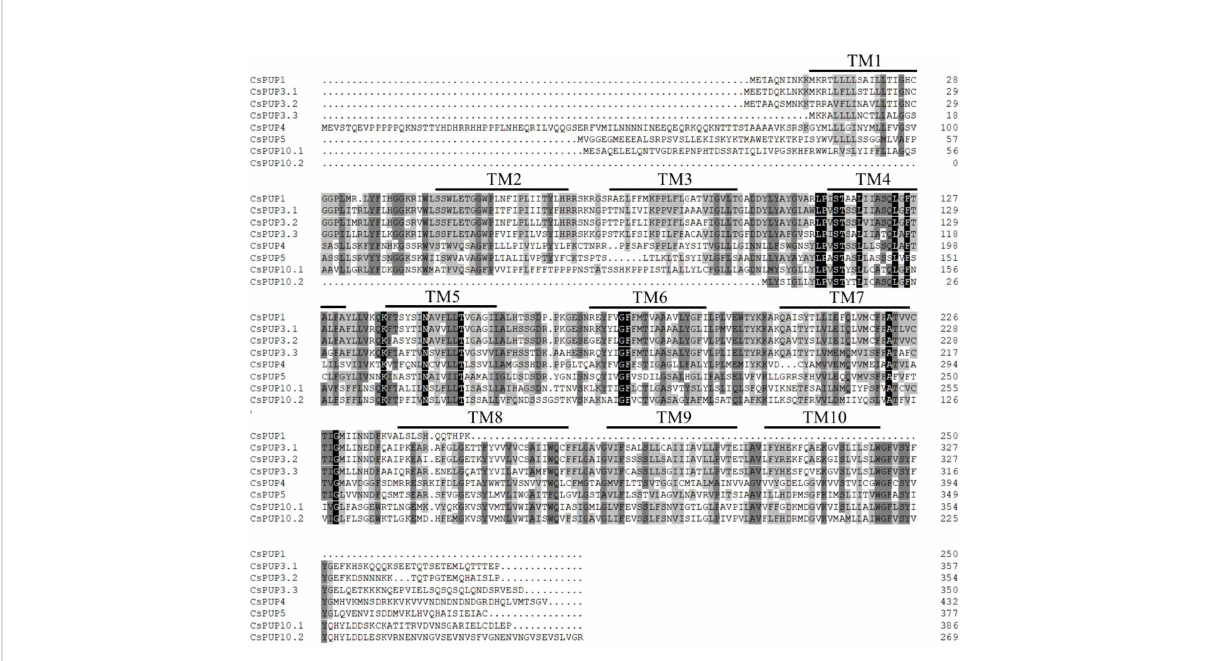
FIGURE 1 Amino acids sequences alignments of